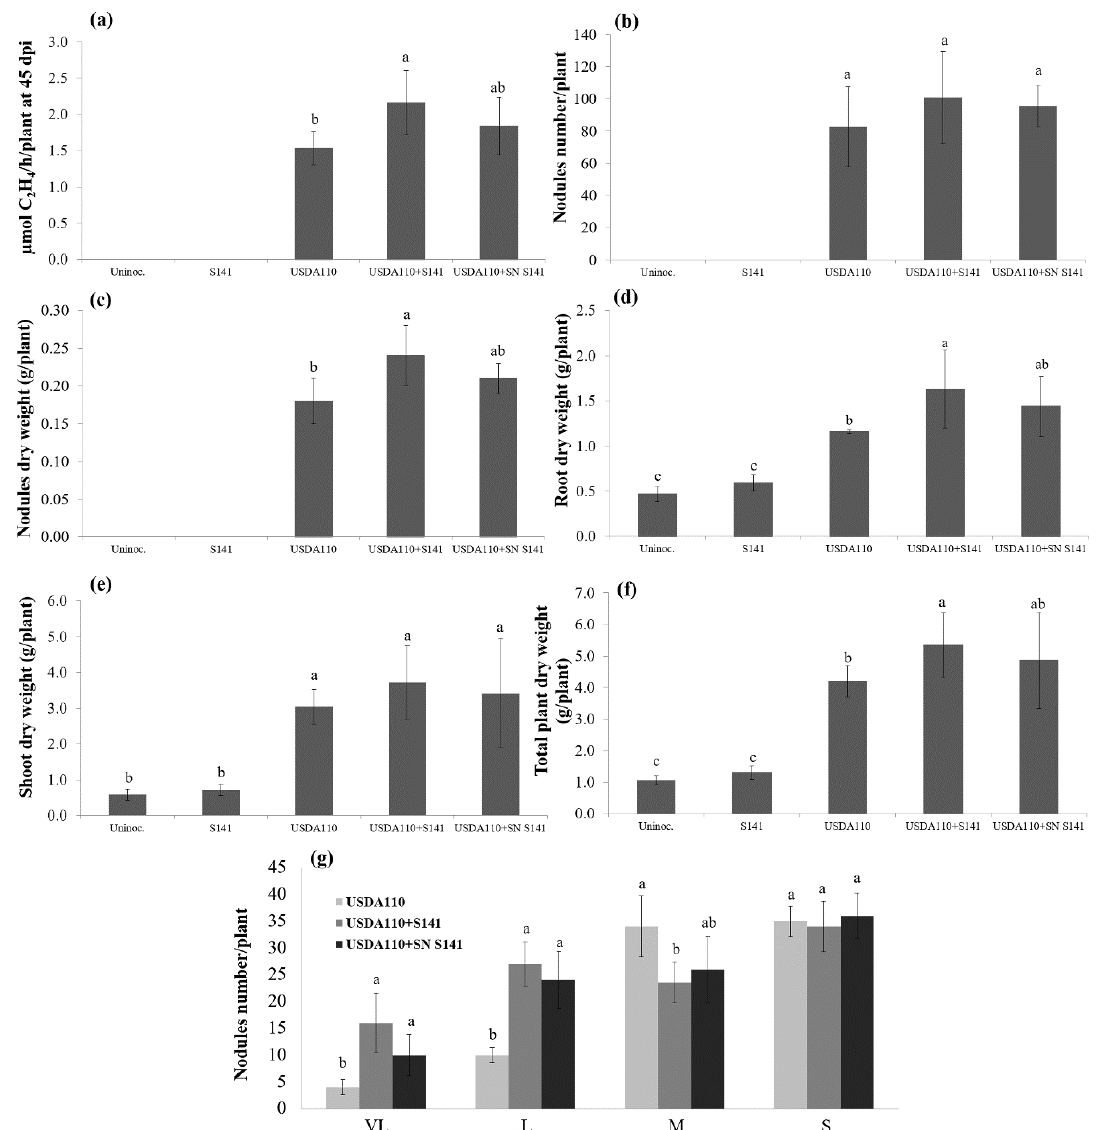
Figure 2. Plant growth and symbiotic parameters of soybean cultivar Chiang Mai 60 by co-inoculation with cells or supernatants of S141 and USDA110 at 45 DAI: ( a ) nitrogenase activity was determined by the acetylene reduction assay; ( b ) nodule numbers per plant; ( c ) nodule dry weight; ( d ) root dry weight; ( e ) shoot dry weight; ( f ) total plant dry weight; and ( g ) nodule size separation. Significance at p ≤ 0.05 is indicated by mean standard error bars (n = 10 ).